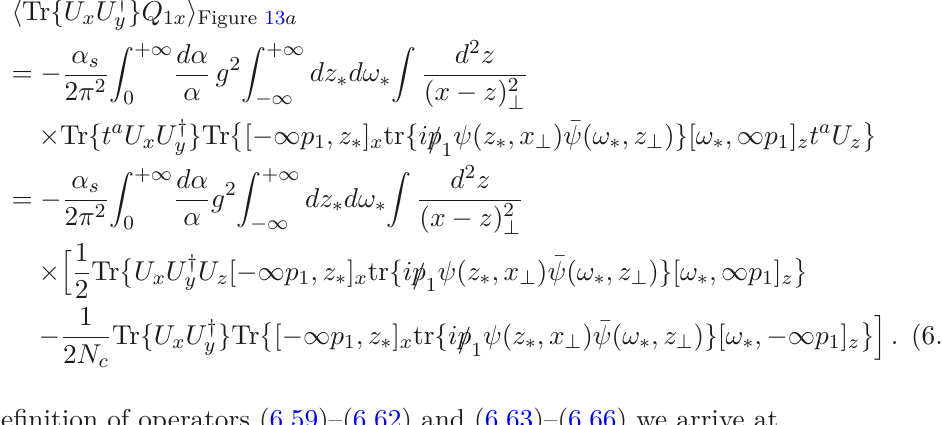
Figure 13 . Quark-to-gluon diagrams for ˆ Q